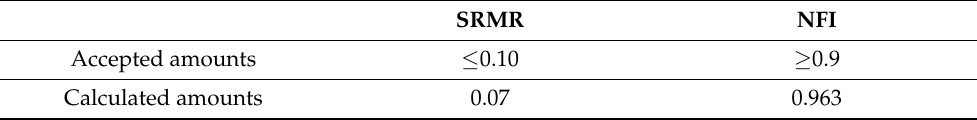
Table 3. Fitness